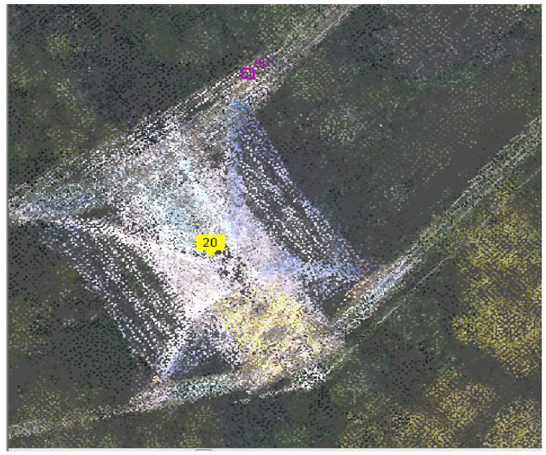
Fig. 5 A recognized transmission tower. The yellow point represents the transmission tower recognized by the proposed method